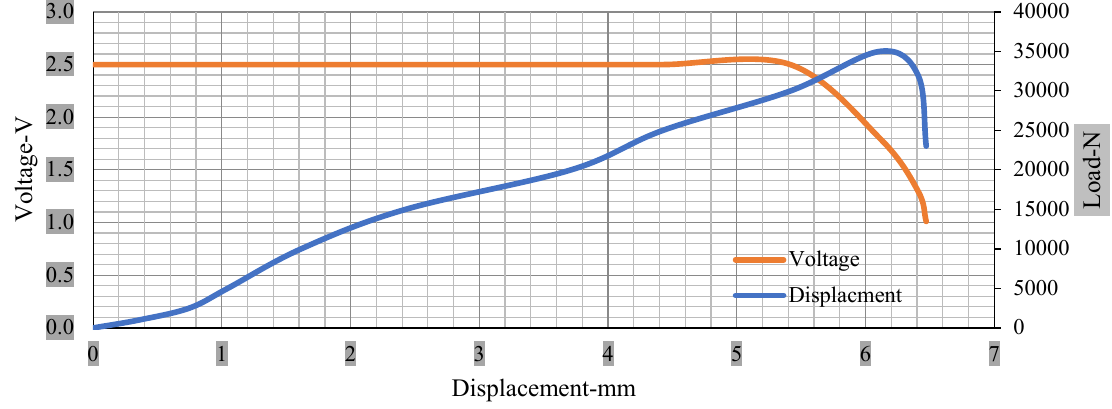
Figure 11. Load and voltage vs. displacement 25 mm punch less than 10% soc.